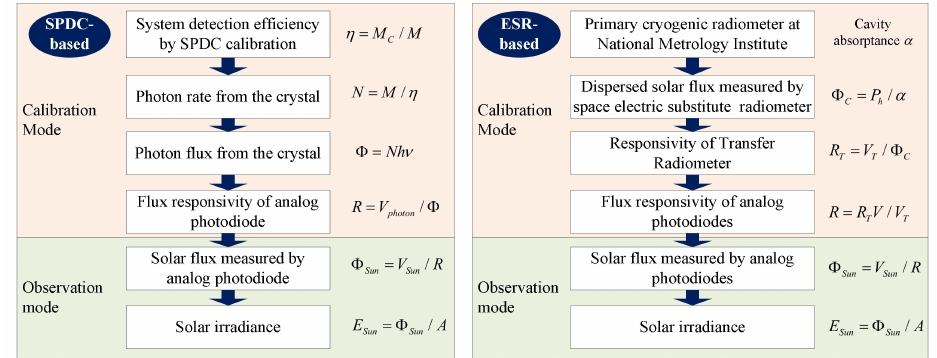
Figure 4. Traceability chain for solar spectral irradiance measurement: ( left ) SPDC-based, and ( right ) electrical substitution radiometer (ESR)-based